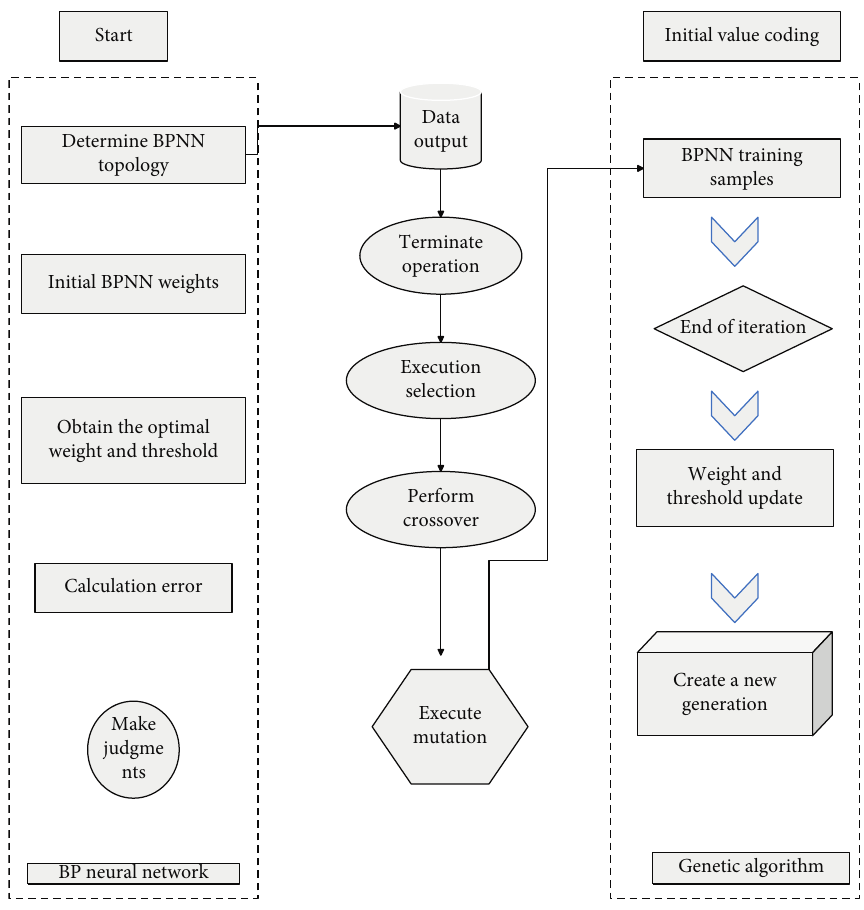
Figure 1: Group intelligence algorithm classification